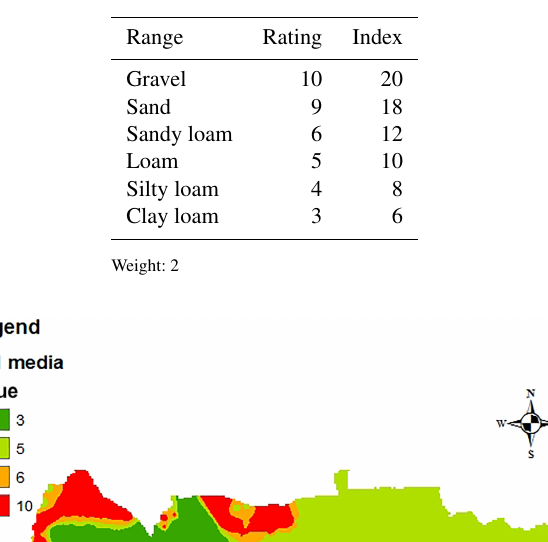
Table 4. Range and rating for soil media.